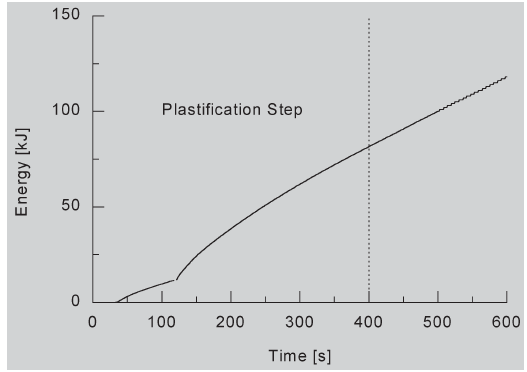
Figure 1: Recording of the energy during a measure- ment at 128 rpm for a 30 % moisture sample at 97.5 °C. The dashed line indicates the time at which the power becomes constant and thus it can be considered as the end of the plastification